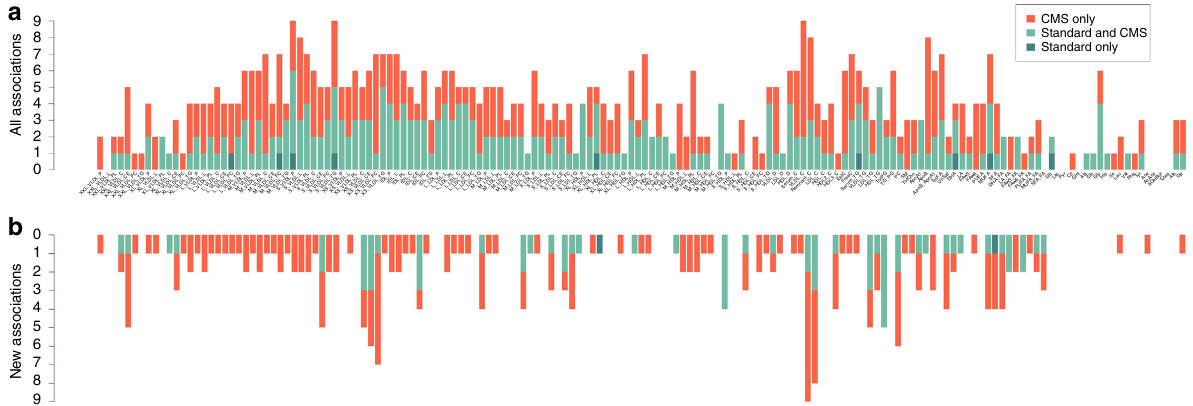
Fig. 1 Region-metabolite associations. Distribution of the 588 signi fi cant associations ( P < 1.28 × 10 − 9 ) identi fi ed in the 158 metabolites GWAS in the METSIM cohort. a Regions in dark green were signi fi cant for standard linear regression adjusted by confounding factors. Regions in red were signi fi cant for linear regression adjusted with confounding factors and covariates selected by CMS. Regions in light green were signi fi cant for both models. b Same plot including only the 228 new associations, not identi fi ed in previous metabolites